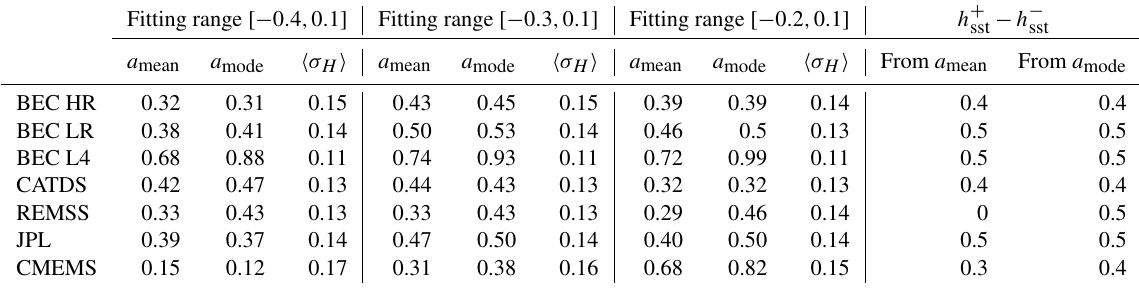
Table 7. Singularity analysis metrics of the SSS products over three different SST SE regimes: [− 0 . 4 , 0 . 1 ] , [− 0 . 3 , 0 . 1 ] , and [− 0 . 2 , 0 . 1 ] . For each one of these regimes we compute the linear regression coefficient of the mean SSS SE as a function of SST SE (mean, ¯ H ( h SST )); the linear regression coefficient of the most probable value of SSS SE as a function of the SST SE (mode, H 0 ( h SST )) and the averaged value of the standard deviation of the SSS SE as a function of SST SE in the corresponding range ( (cid:104) σ H (cid:105) ). Fitting range [− 0 . 4 , 0 . 1